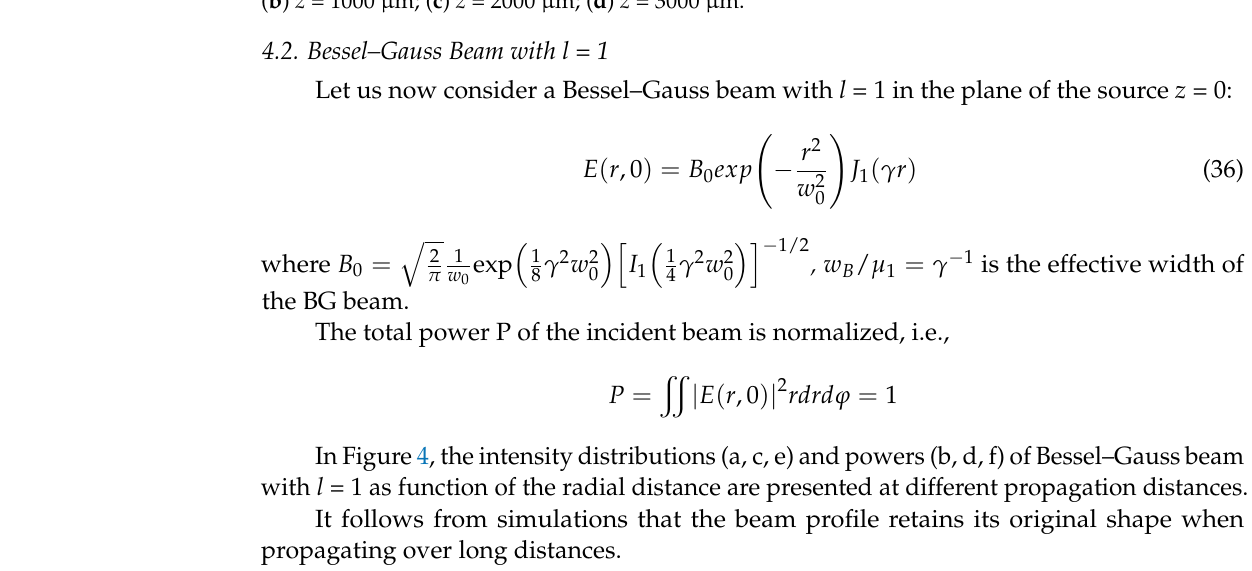
Figure 3. Intensity distributions of BG beam with l = 0; w 0 = 30 mm; w B = 20 mm; l = 0.63 µ m. ( a ) z = 0; ( b ) z = 1000 µm; ( c ) z = 2000 µm; ( d ) z = 3000 µm.